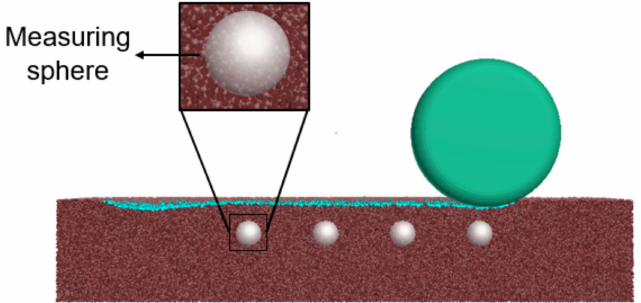
Figure 3. Measuring spheres equally placed beneath the travel